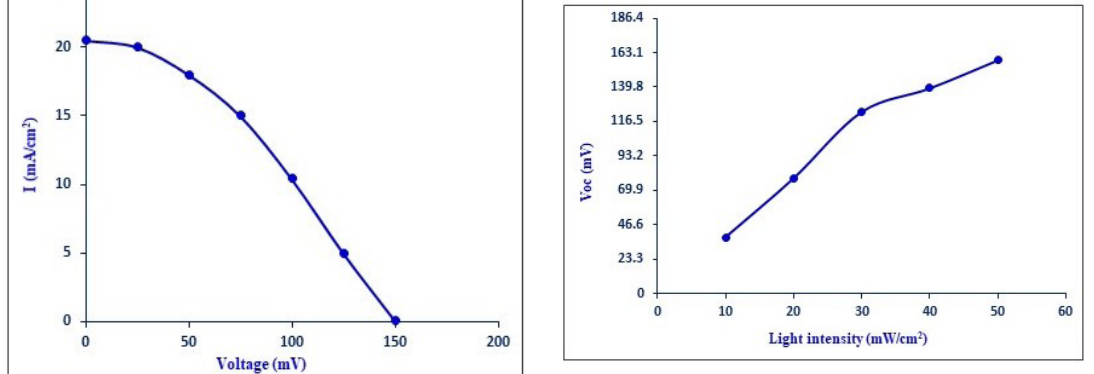
Figure 9. Power output curves for Cu